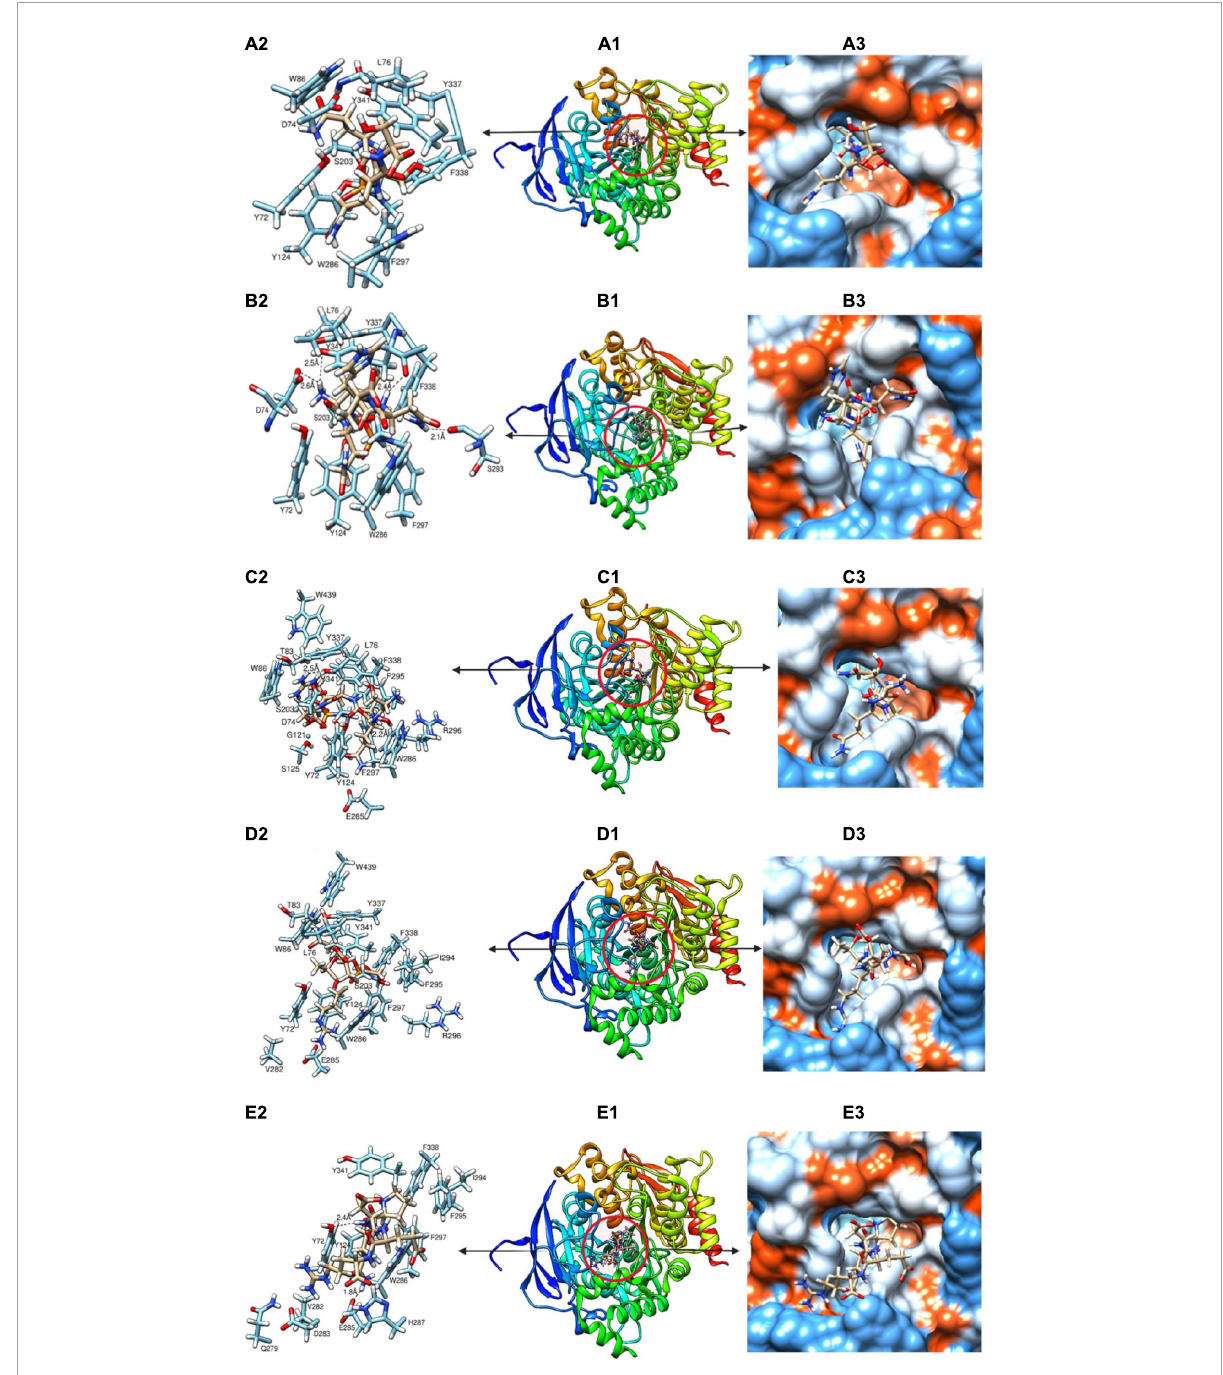
FIGURE7 (A-E) Molecular docking models showing the binding pattern of QSQS (A1) , LQHNA (B1) , SQSRS (C1) , ETRSQ (D1) and PQDER (E1) to the active site of acetylcholinesterase. Amino acids interacting within 3Å (A2, B2, C2, D2, and E2) and Kyte-Doolittle scale (A3, B3, C3, D3, and E3) depicting charge environment and hydrophilicity / hydrophobicity of the binding site with colors ranging from dodger blue for the most hydrophilic to white 0.0 to orange red for the most hydrophobic.